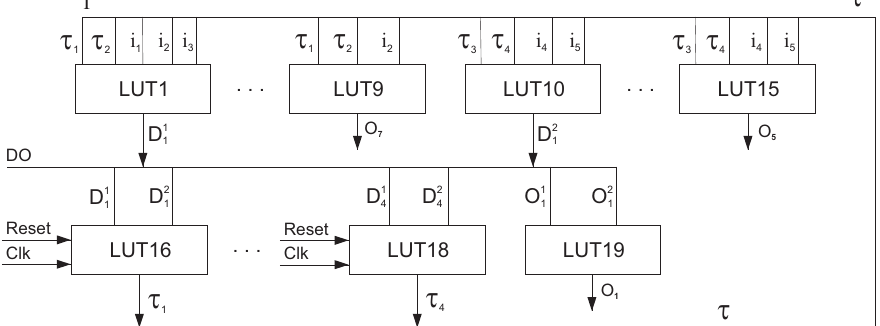
Figure 6. Logic circuit of FSM P E ( A 0 )